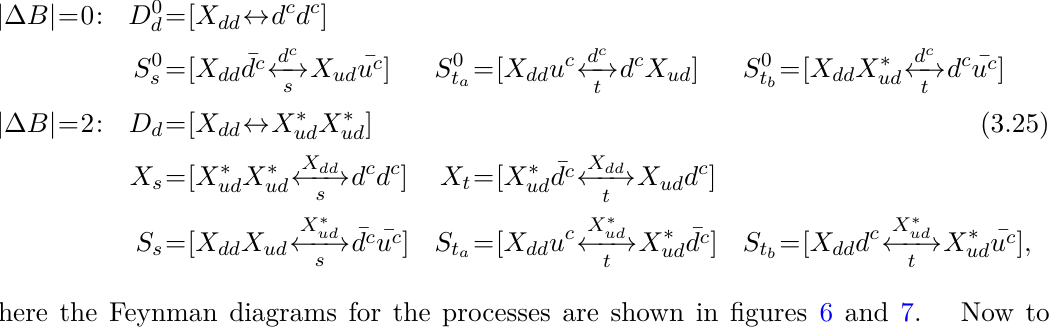
where Γ( X ) and Γ( X ∗ ) are the decay widths for the decays → X ∗ X ∗ → X X dd ud ud ud ud dd and X ∗ , respectively. The total decay width Γ tot ( X X → X ∗ X ∗ → X X dd ud ud ud ud dd Γ( X ) + Γ( X → X ∗ X ∗ → d c d c ) , x is defined as x ≡ m 2 dd dd ud ud